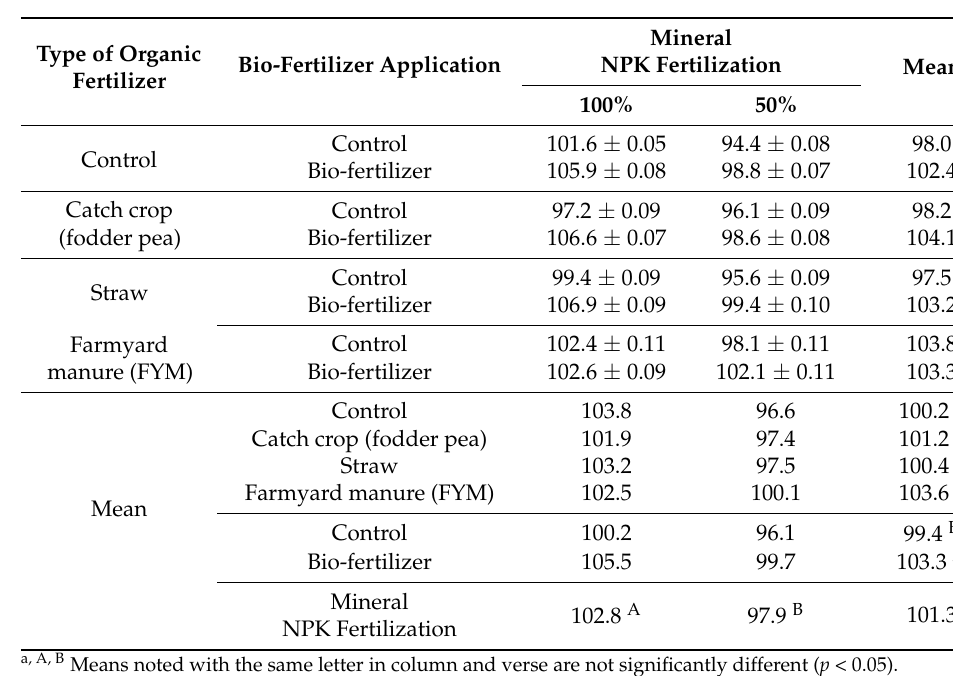
Table 4. Total protein content in potato tubers after 6 months of storage depending on the applied research factors (g · kg − 1 of dry weight) (mean from 3 years).